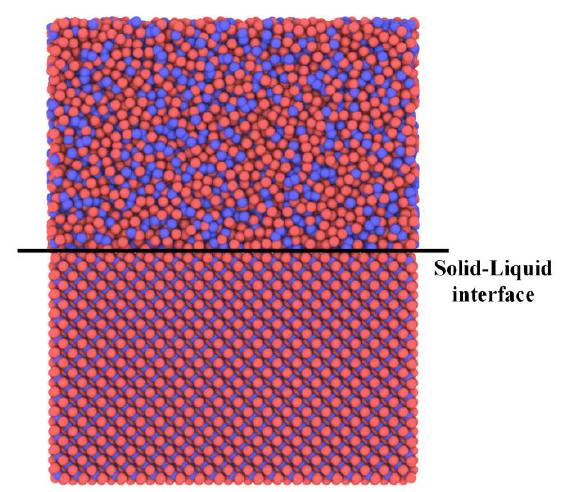
Figure 8. The typical crystal growth simulation model of SiC [74].